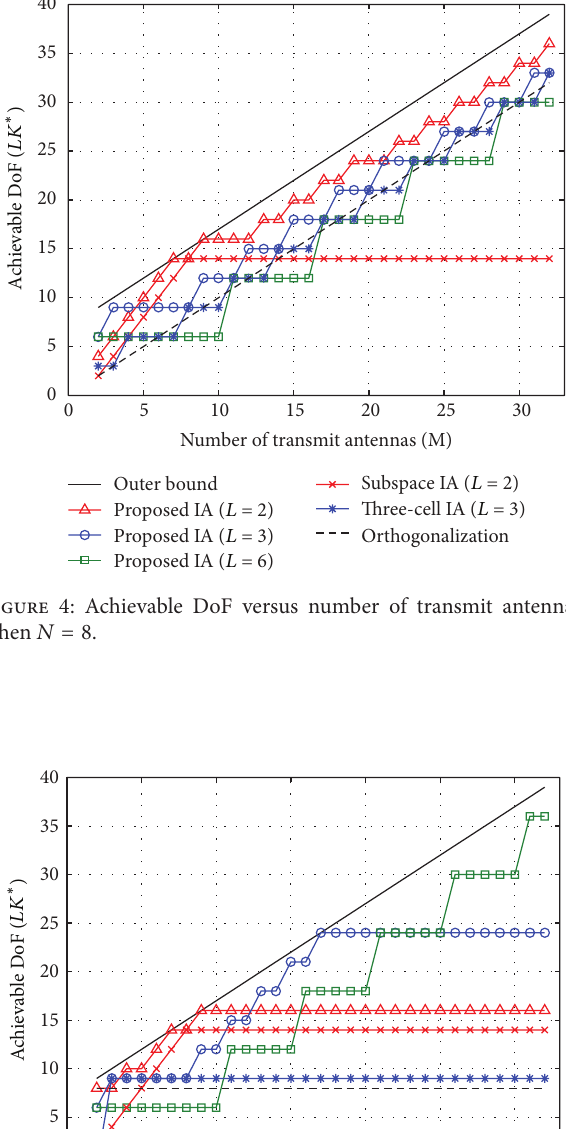
DoF of the orthogonal scheme is limited by the number of transmit antennas 𝑀 . From two results of Figures 4 and 5, we can choose appropriate parameters, 𝐿 , 𝑀 , and 𝑁 , to achieve maximum